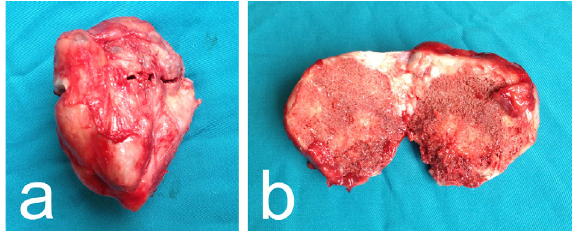
Figure 3. (a, b) The photograph shows the mass consisting of cancellous bone with a thin cartilage-like